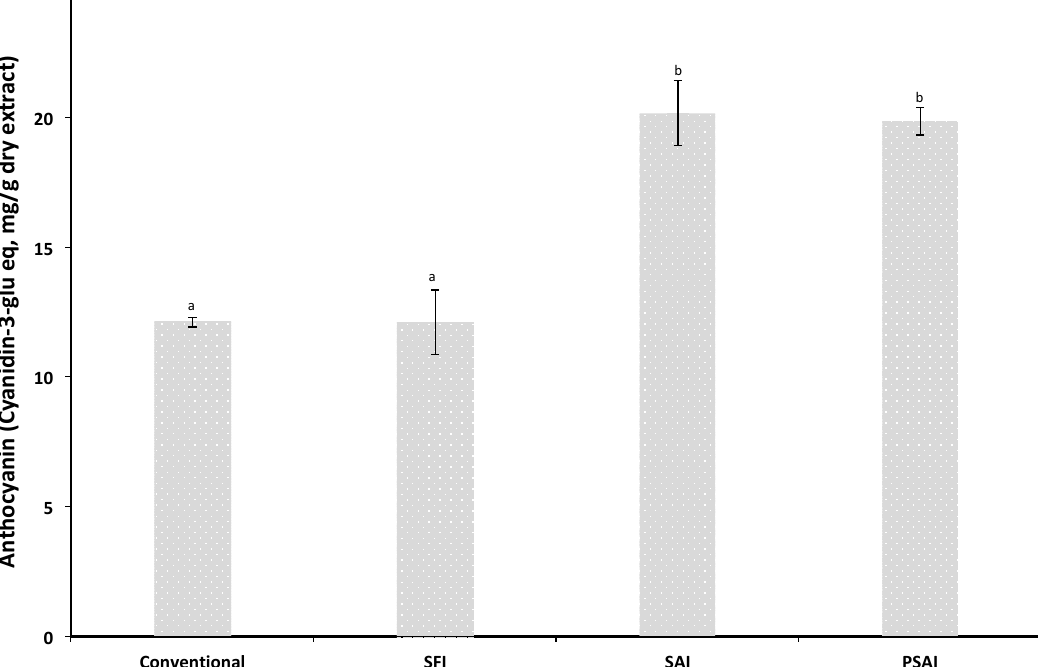
Table 3. Putative identification of anthocyanins present in the chromatograms obtained after analysis by HPLC ‐ MS/MS of the extracts of strawberry ‐ tree fruit obtained after microwave irradiation and their corresponding retention time (Rt), maximum absorption wavelength ( λ max ), precursor ion ([M + H] + ) and product ions obtained by MS/MS. Retention Time (min) λ max (nm) [M + H] + m/z